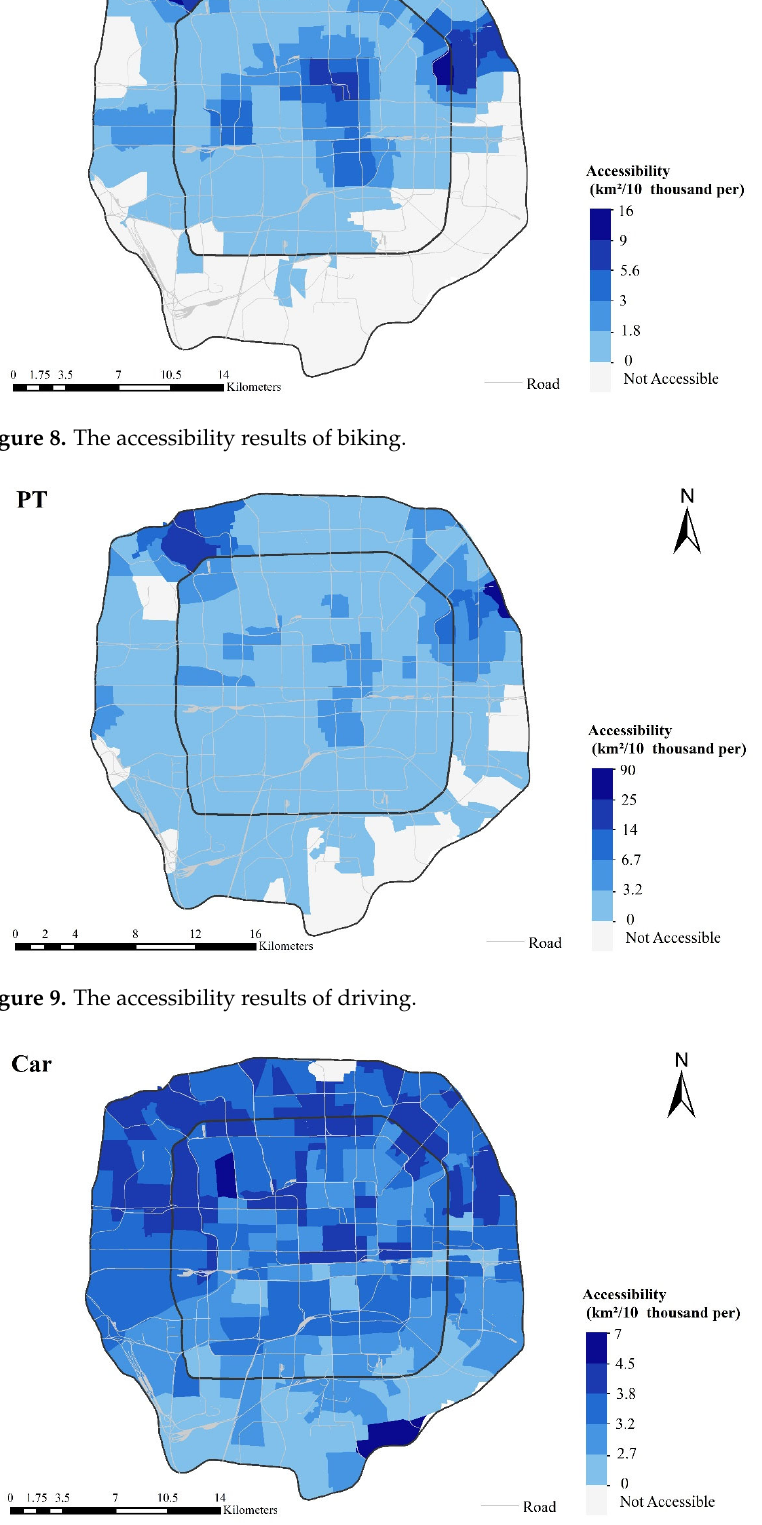
Figure 10. The accessibility results of public transport.